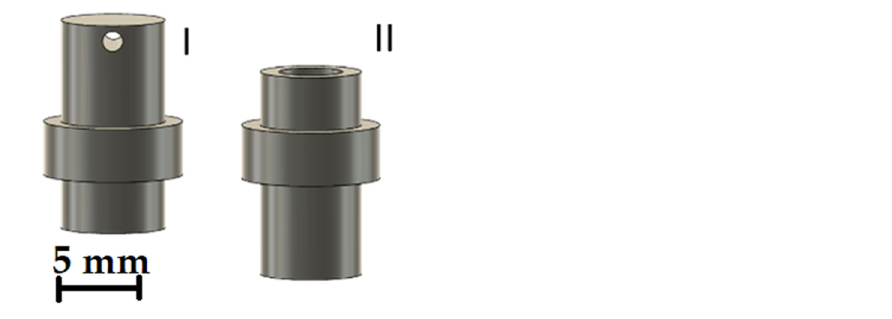
Figure 17. Switching mechanism to change the diameter of the capillary path.